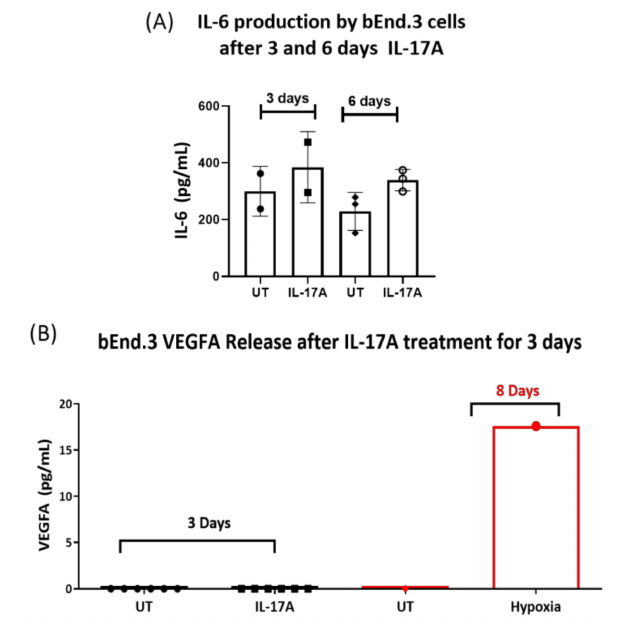
Figure A5. IL-17A may mediate release of IL-6, but not VEGFA, from bEnd.3 cells. Supernatants from control of IL-17A treated bEnd.3 cells were collected at relevant time points. The concentrations of IL-6 and VEGF were measured by ELISA. ( A ) The levels of IL-6 in bEnd.3 cell supernatant after 3 and 6 days of treatment with IL-17A. Mean ± SD, n = 2. ( B ) The levels of VEGFA in the supernatants from bEnd.3 cells after 3 days IL-17A treatment (black dots). Supernatants from bEnd.3 cells exposed to hypoxia (1% oxygen) for 8 days (red dots) were used as a positive control. Each point is representative of one technical replicate. Mean ± SD. UT, untreated; IL-17A, treated with 100 ng/mL of IL-17A.